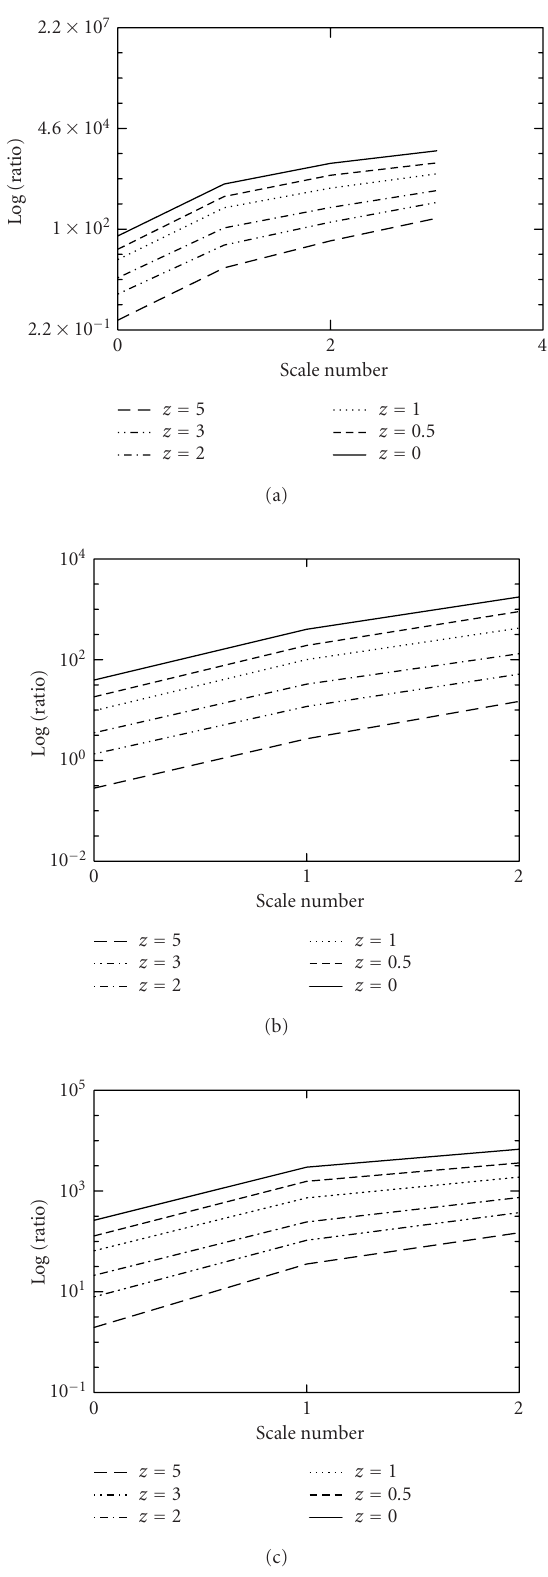
Figure 15: (a) Wavelet spectrum, (b) beamlet spectrum, and (c) ridgelet spectrum at di ff erent